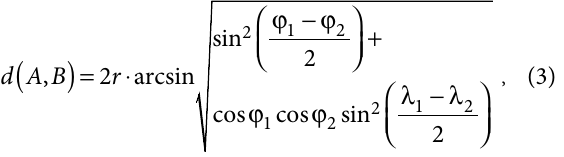
ates; λ , λ – A and B longitude coordinates (Eddie 2012). 1 2